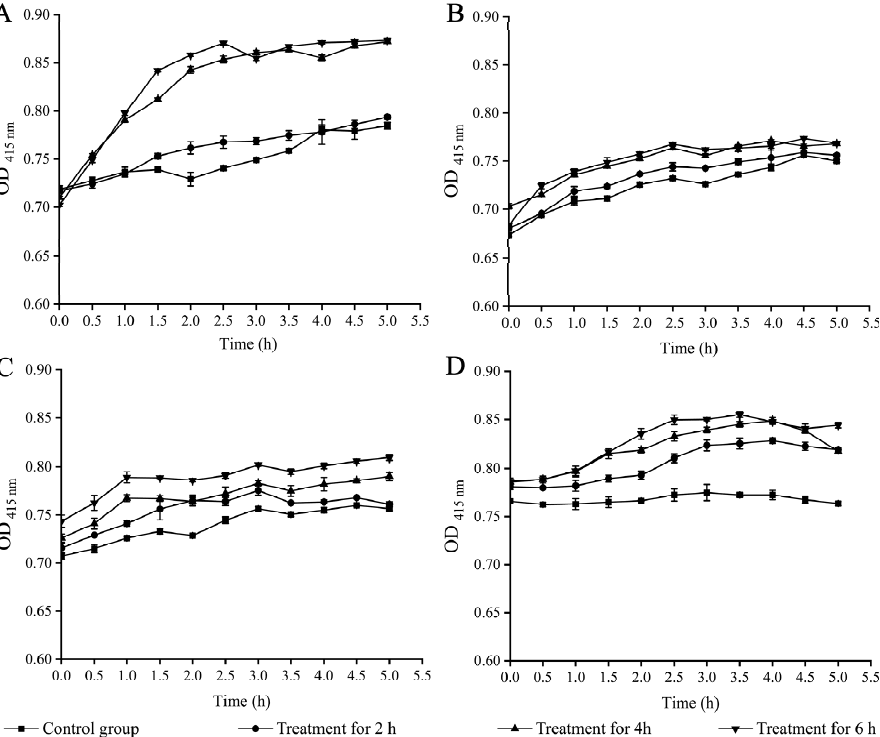
Figure 3. Effects of Fragment 1 from C. communis Linn on bacterial inner cell membrane permeability. Results presented as means ± S.D. of three repetitions. ( A – D ) B. cereus A1 ‐ 1, E. faecalis C1 ‐ 1, S. aureus ATCC25923, and S. enterica subsp. enterica ( ex Kauffmann and Edwards) Le Minor and Popoff serovar Vellore ATCC15611, respectively. In conclusion, these results indicated that Fragment 1 from C. communis Linn can af ‐ fect cell membrane structures of S. enterica ATCC15611, E. faecalis C1 ‐ 1, S. aureus ATCC25923 and B. cereus A1 ‐ 1, particularly increasing cell surface hydrophobicity and membrane permeability, but reducing membrane fluidity, and significantly damage cell membrane structures, in agreement with bacterial surface structure changes observed by scanning electron microscopy (SEM) analysis (see below). The damage to cell membranes was conducive to the penetration of fragment 1 of C. communis Linn into bacterial cells, consequently influencing intracellular metabolisms and thereby inhibiting bacterial growth and even leading to bacterial death.